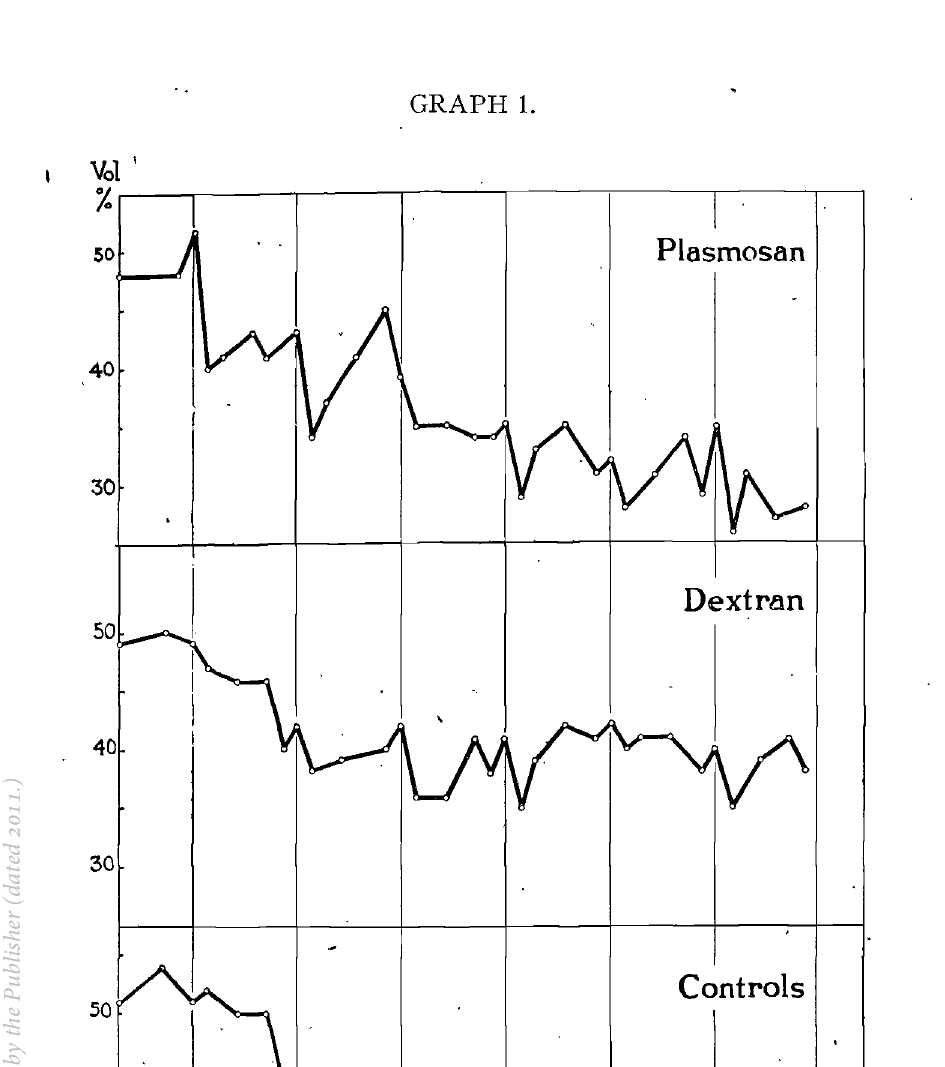
The Percentage Red Cell'